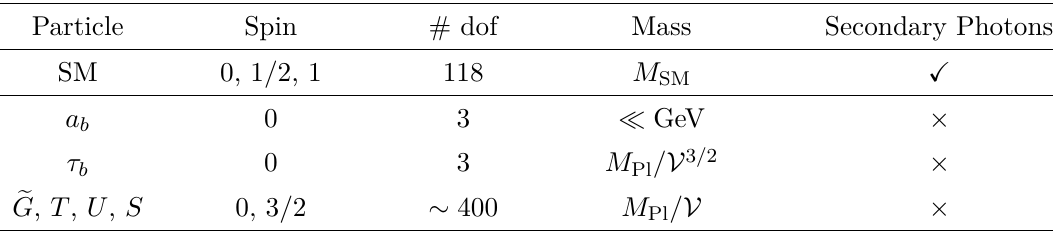
Table 3 . Particle content of the string theory inspired models with masses less than ∼ 10 7 GeV.